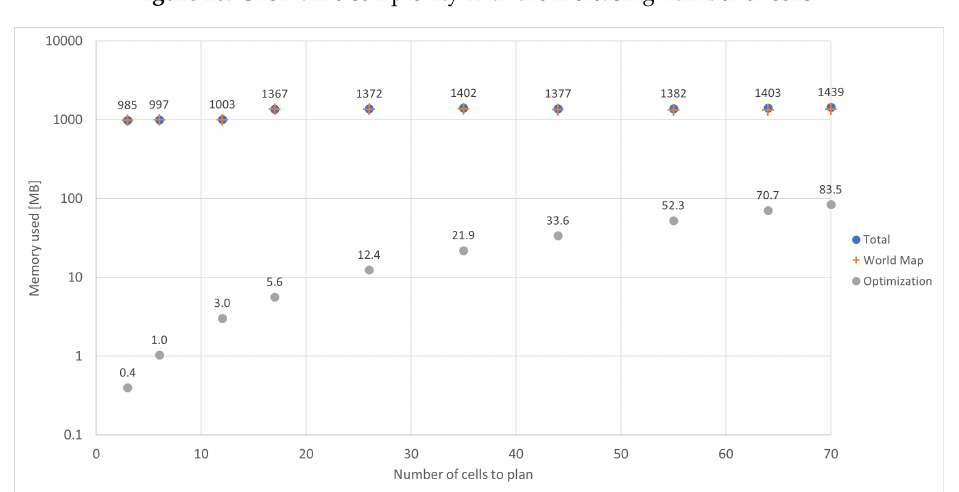
Figure 18. CPSP time complexity with the increasing number of cells.